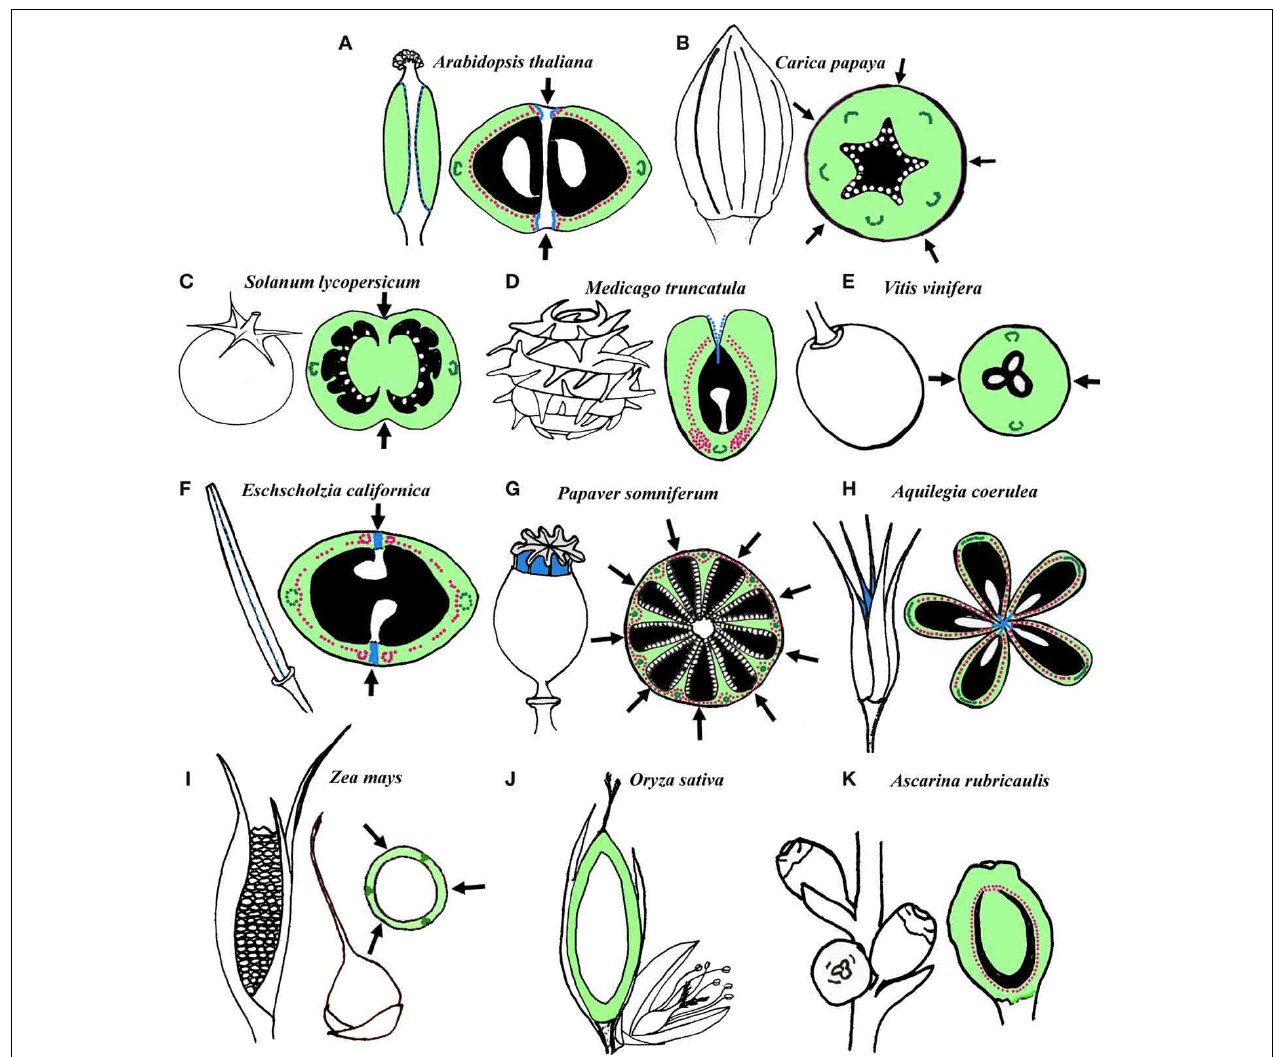
FIGURE 1 | Schematic representation and transverse/longitudinal sections of several fruits. (A–E) Examples of fruits in core eudicots. (A) Operculate capsule of Arabidopsis thaliana (Brassicaceae) derived from a bicarpellate and bilocular syncarpic gynoecium. (B) Berry of Carica Papaya (Caricaceae) derived from a pentacarpellate and unilocular syncarpic gynoecium. (C) Berry of Solanum lycopersicum (Solanaceae) derived from a bicarpellate and bilocular gynoecium. (D) Dehiscent pod of Medicago truncatula (Fabaceae) derived from a recurved single carpel. (E) Berry of Vitis vinifera (Vitaceae) derived from a bicarpellate and unilocular gynoecium. (F–H) Examples of fruits in basal eudicots. (F) Longitudinally dehiscent capsule of Eschscholzia californica